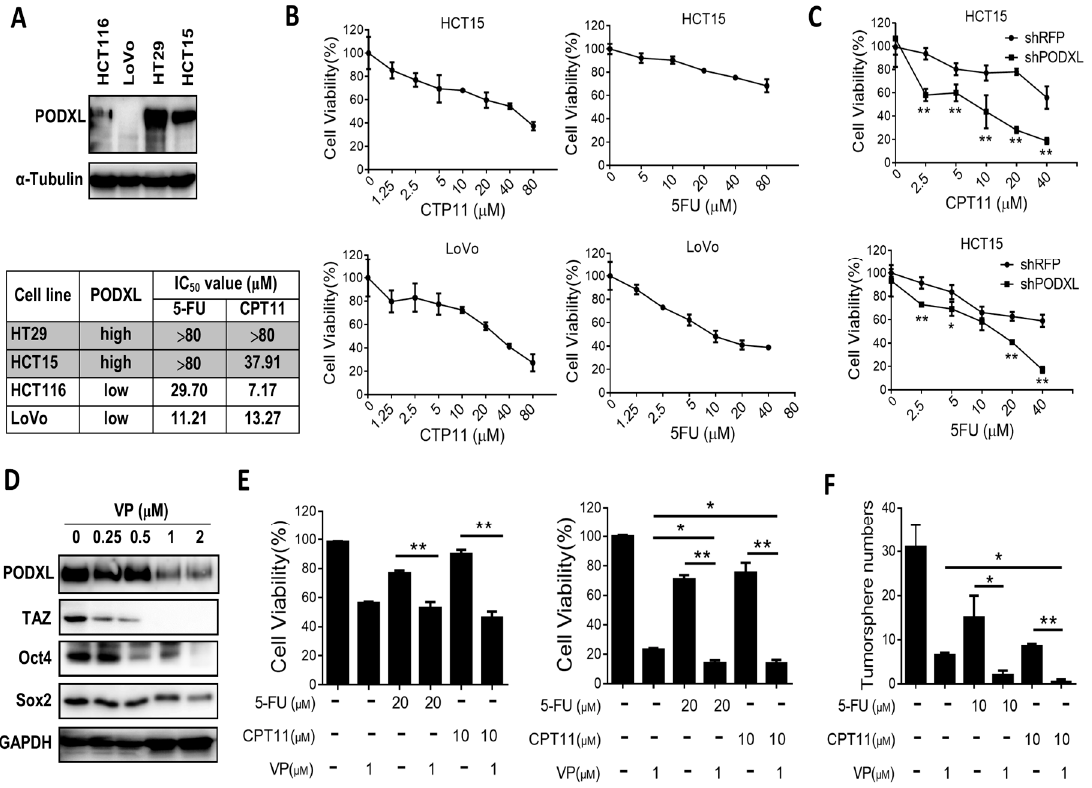
Figure 5. Expression of PODXL confers resistance to conventional chemotherapies in colorectal cancer. ( A ) Western blot analysis of the PODXL protein level in CRC cell lines. ( B ) Determination of 50% inhibitory concentration (IC 50 ) values of 5-fluorouracil (5-FU) and irinotecan (CPT11) toward CRC cells. CRC cells were treated with various concentrations of 5-FU or CPT11 for 48 h, and cell viability was measured by MTT assay. Results are shown as the mean ± standard error of the mean ( n = 3). The IC 50 value was obtained using the GraphPad Prism5 program. ( C ) Knockdown of PODXL increased sensitivity in response to chemotherapies. 5-FU and CPT11 (0–40 µ M) were added in mock and PODXL knockdown HCT15 cells for 48 h, and cell viability was measured by MTT assay. ( D ) HCT15 cells were treated with verteporfin (VP) for 24 h, and protein expression was analyzed by Western blotting. ( E ) HCT15 cells were treated with 5-FU or CPT11 in the presence or absence of VP for 24 (left panel) or 48 h (right panel), and cell viability was measured by MTT assay. Results are shown as the mean ± standard error of the mean ( n = 3). ( F ) HCT15 cells were treated with 5-FU or CPT11 combined with VP, and formation of tumorsphere was assessed. A two-tailed Student’s t -test was applied to determine the statistical significance of the indicated groups. * p < 0.05, ** p < 0.01.